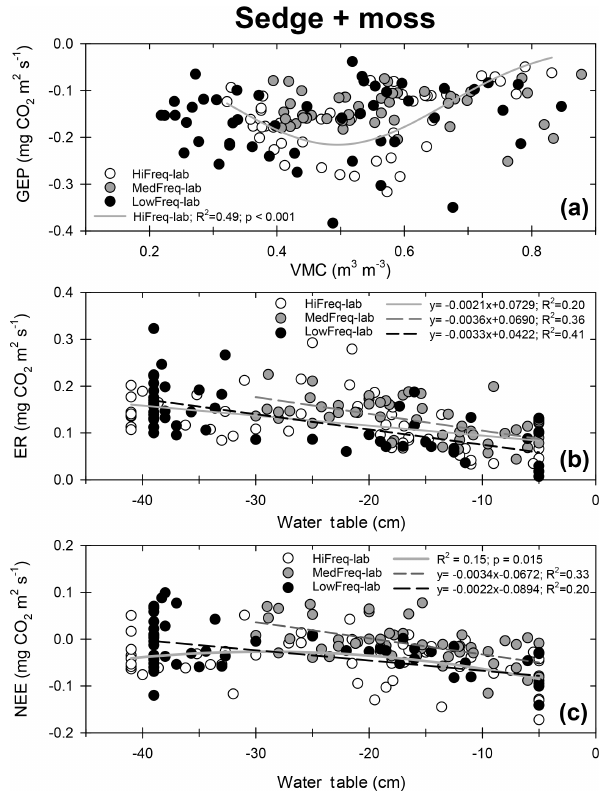
Figure 6. Hydrologic controls on CO 2 exchange in C. oligisperma -dominated monoliths, depicting relationships in (a) GEP, (b) ER, and (c) NEE between rainfall frequency treatments. Relationship in (a) is unimodal with indicated correlation coefficients and signifi- cance. Relationships in (b) and (c) are linear and are indicated with correlation coefficients. All regressions in (b) and (c) were statisti- cally significant ( p < 0 . 001).